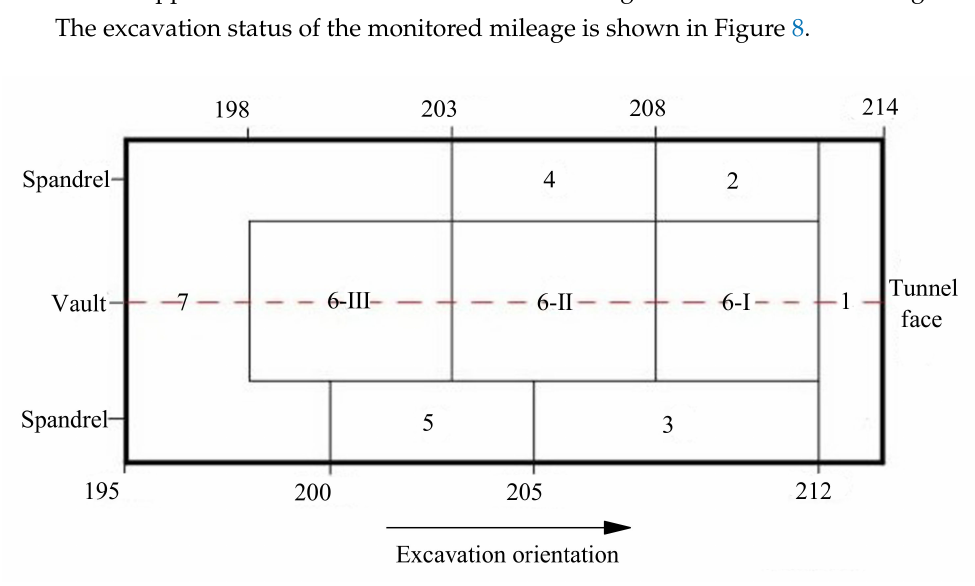
Figure 8. The excavation status of the monitored